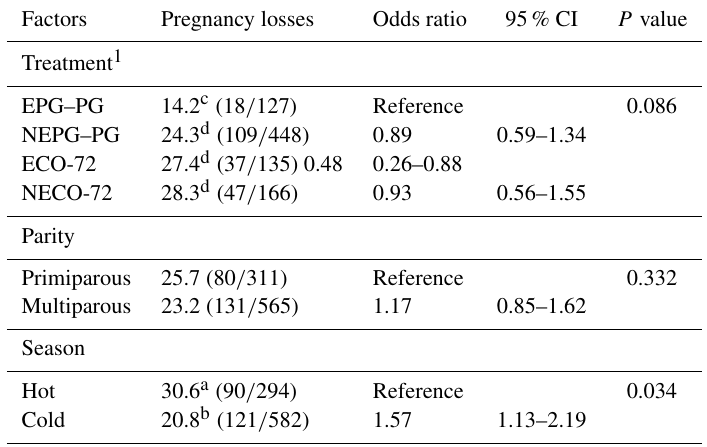
CI is confidence interval. 1 Cows showing estrus during the postpartum period received the CO-72 (EPG–PG): (GnRH + PGF 2 α 1 + PGF 2 α 2 + GnRH + TAI 48h after PGF 2 α 2 ) or ECO-72